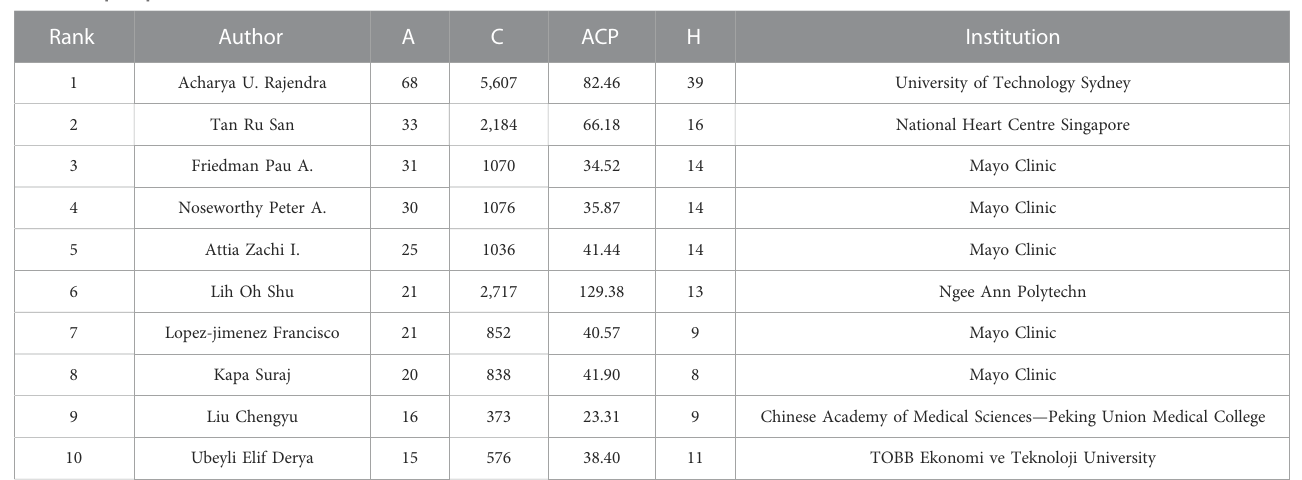
TABLE 3 Top 10 productive